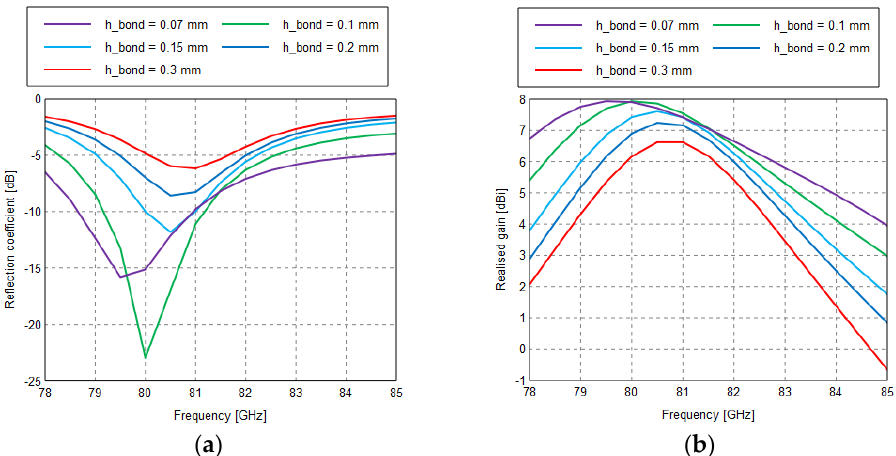
Figure 5. Simulations of the experimental design having different wire bond heights: ( a ) reflection coefficient; ( b ) realized gain (reflection loss included), broadside direction.